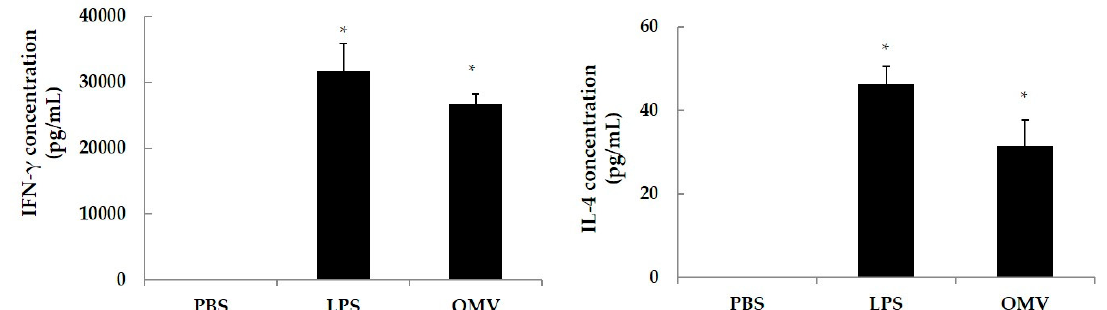
Figure 4. Cytokine production by spleen cells from non-immunized BALB / c mice stimulated in vitro with OMV. Spleen cells from naïve mice were in vitro stimulated with OMV (40 µ g / mL), using LPS from E. coli at 10 µ g / mL as a positive control and PBS as negative control. The levels of IFN- γ and IL-4 released were determined after 48 h treatment. The results are shown as the mean levels for triplicate cultures ± SD. Cytokine levels were significantly greater (* p < 0.05) than those in supernatants from splenic cells incubated with PBS.